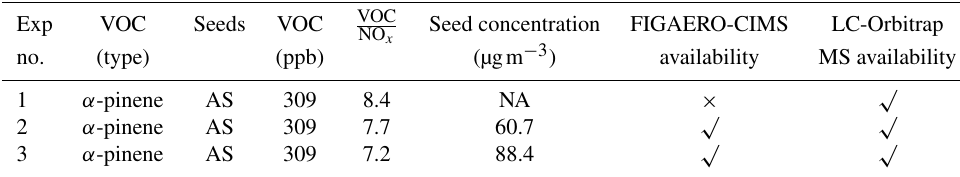
Table 1. The initial experimental conditions and instrument availability. Exp VOC Seeds VOC VOC Seed concentration FIGAERO-CIMS LC-Orbitrap NO x no. (type) (ppb) (µgm − 3 ) availability MS availability √ 1 α -pinene AS 309 8.4 NA × √ √ 2 α -pinene AS 309 7.7 60.7 √ 3 α -pinene AS 309 7.2 88.4